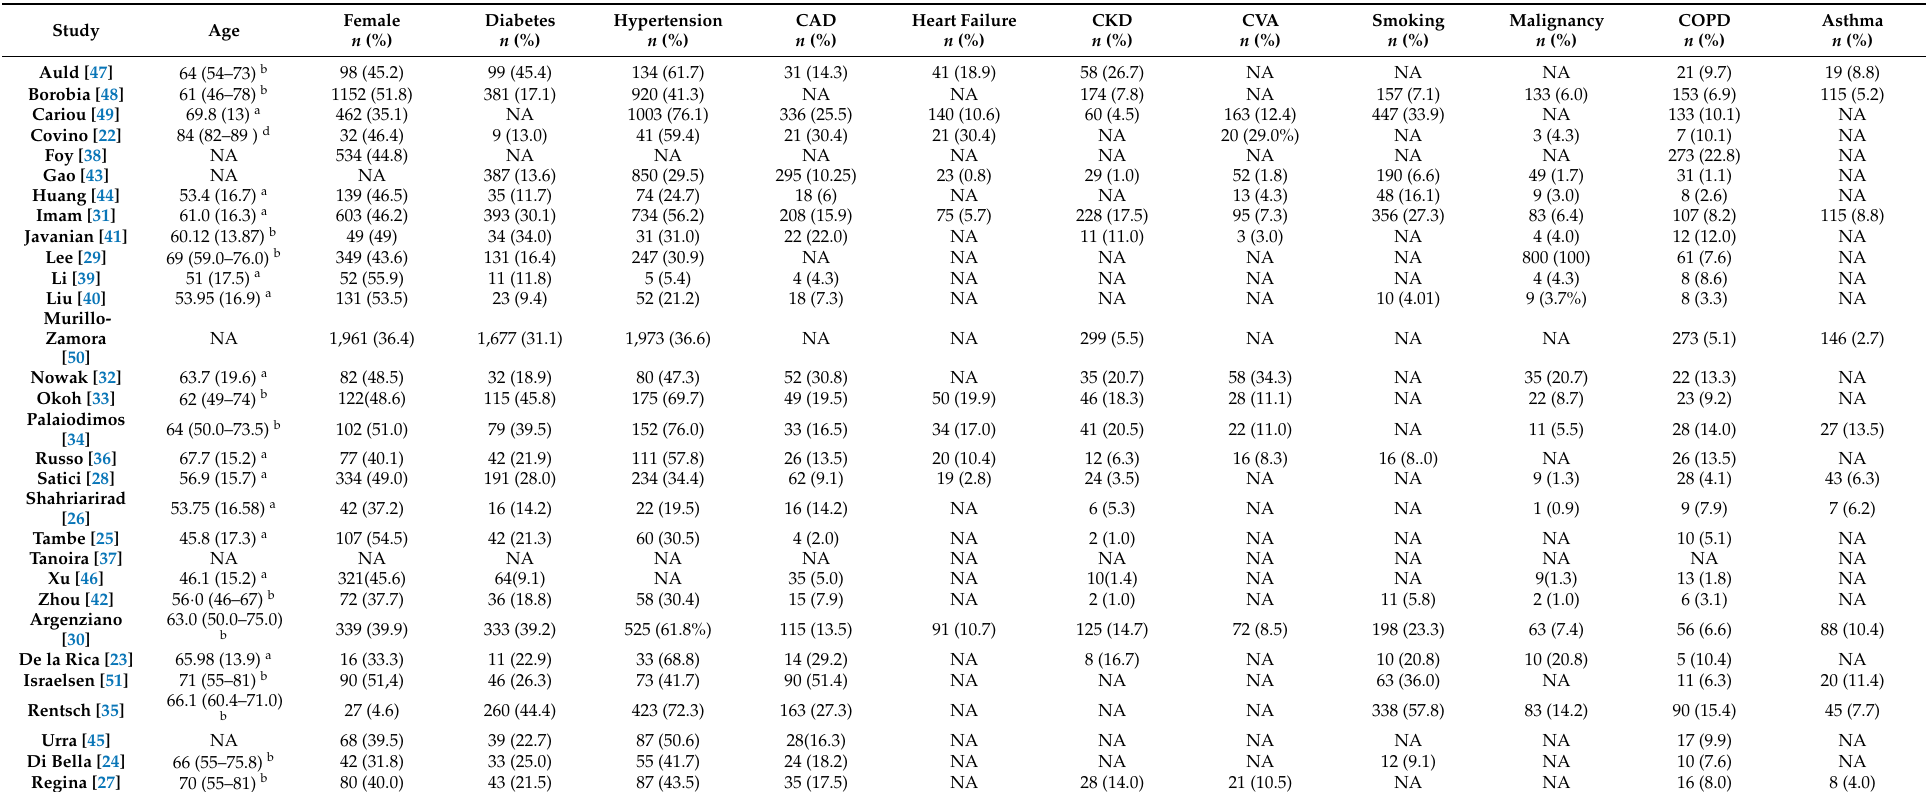
Table 2. Baseline characteristics of patients per included studies. Described in absolute and relative